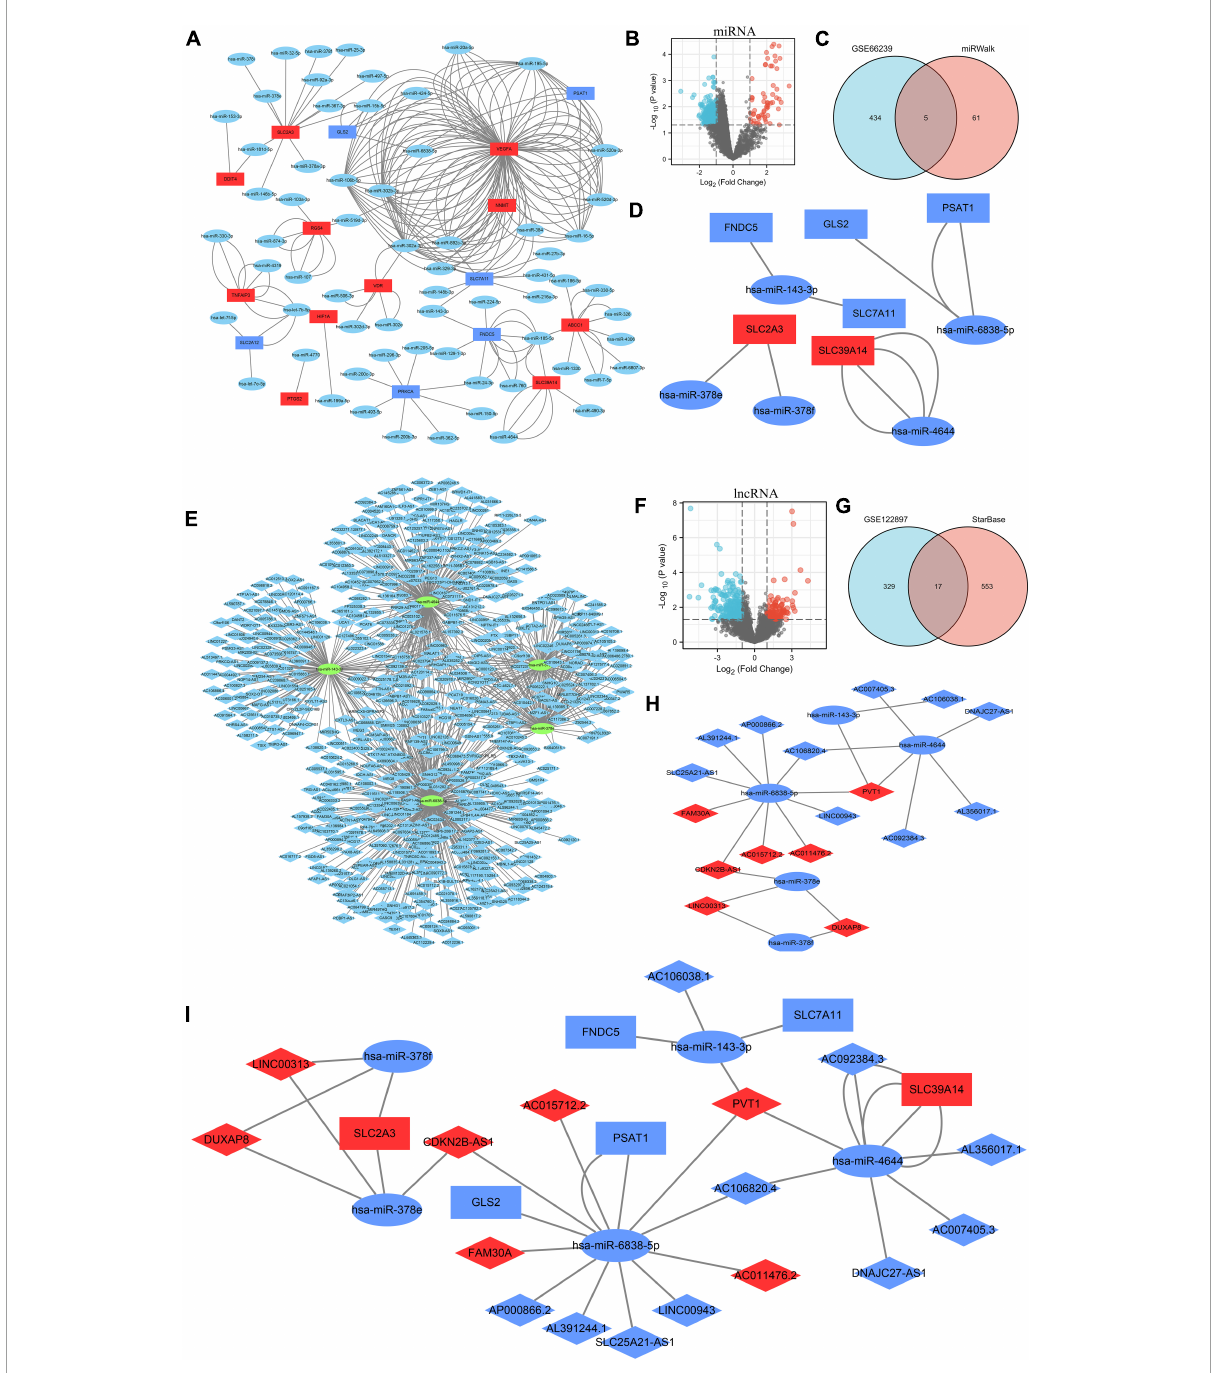
FIGURE4 Construction of the triple regulatory network of differentially expressed lncRNAs (DELs), differentially expressed miRNAs (DEMs), and ferroptosis DEGs. (A) The interaction network between ferroptosis DEGs and the targeted miRNAs. (B) Volcano plot of DEMs in GSE66240. (C) Venn diagram of DEMs and potentially targeted miRNAs encoding ferroptosis DEGs. (D) Interaction network between the overlapped DEMs and the ferroptosis DEGs. (E) Interaction network between the overlapped DEMs and the targeted lncRNAs. (F) Volcano plot for DELs of GSE122897. (G) Venn diagram of DELs and the potentially targeted lncRNAs of the overlapped DELs. (H) Interaction network of the overlapped DELs and DEMs. (I) Triple regulatory network of the overlapped DELs, overlapped DEMs, and ferroptosis DEGs. MiRNAs are represented by ellipses, mRNAs by rectangles, and lncRNAs by diamonds. Navy-blue signifies downregulation and red